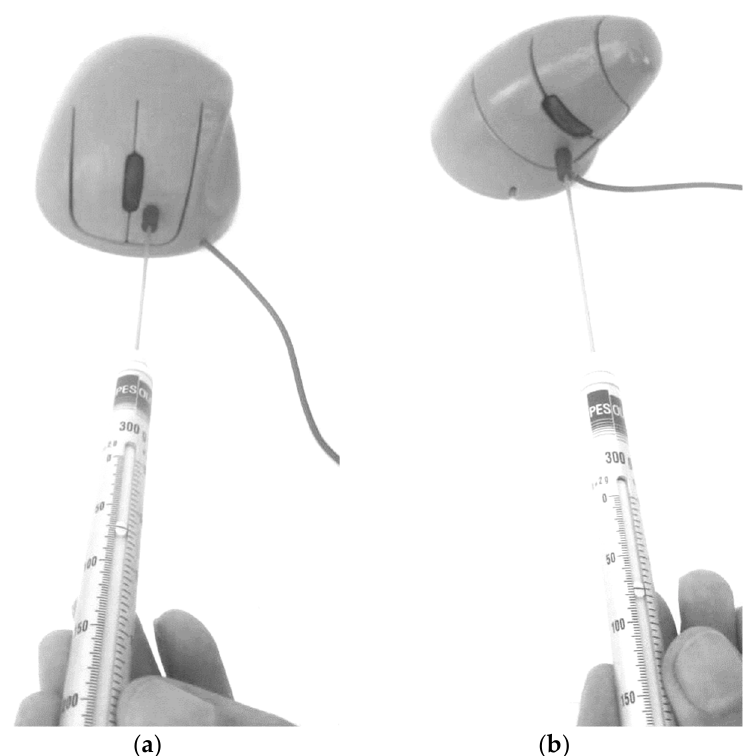
Figure 8. Measuring the force required to activate the buttons and dimensions of the PC mice’s fully functional prototypes. ( a ) ch prototype, force required to activate the buttons (70 gf = 0.687 N); ( b ) ci prototype, force required to activate the buttons (80 gf = 0.785 N).